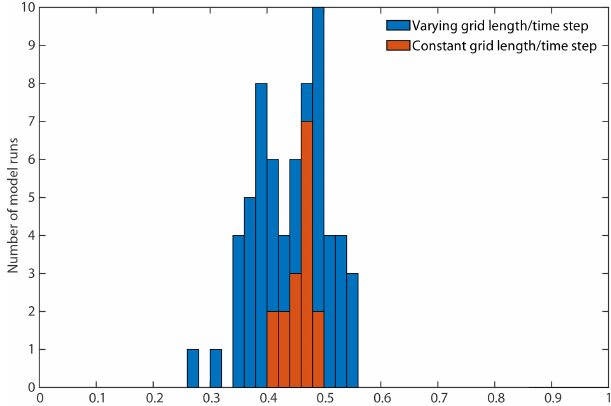
Figure 10. Variability in the inlet fraction of the transgressive sedi- ment flux F for varying grid lengths (cid:49)y and time steps (cid:49)t and for constant (cid:49)y and (cid:49)t , highlighting the fraction of the variability in F due to inherent model